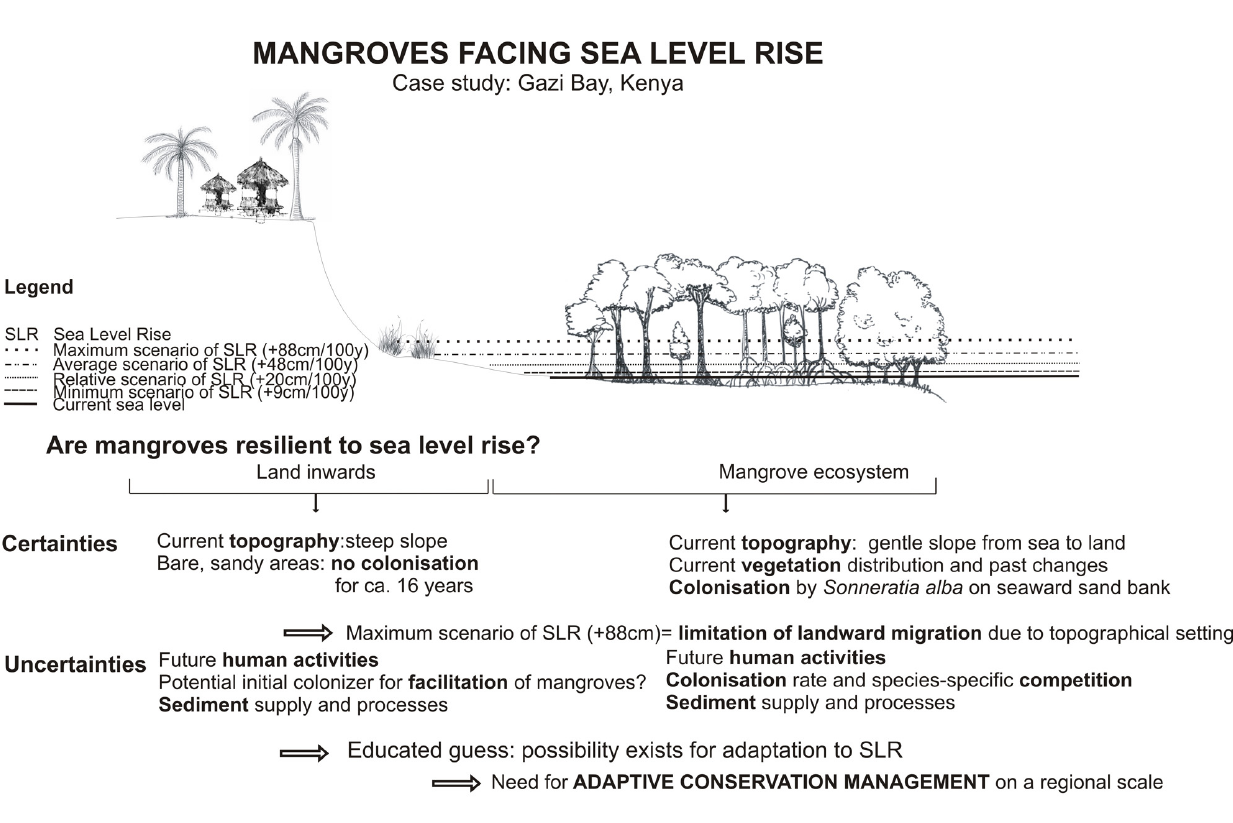
Fig. 4. Overview scheme summarising the discussion on resilience of mangroves facing sea level rise, more specifically concerning the case study in Gazi Bay